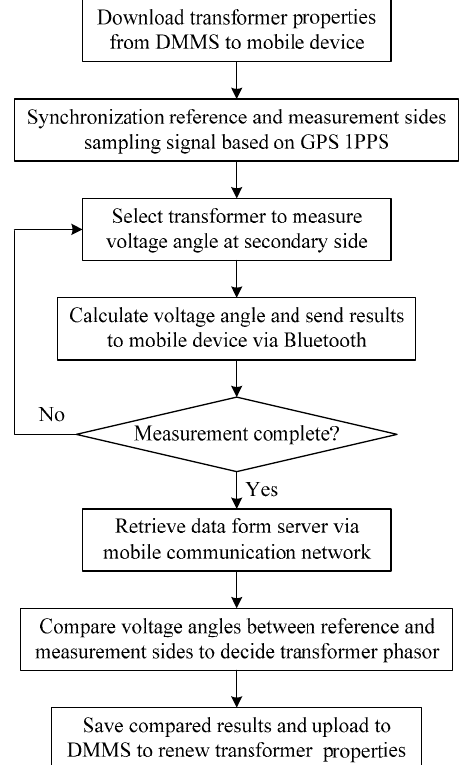
Figure 8. Flow chart of the APP used at the on-site measurement.